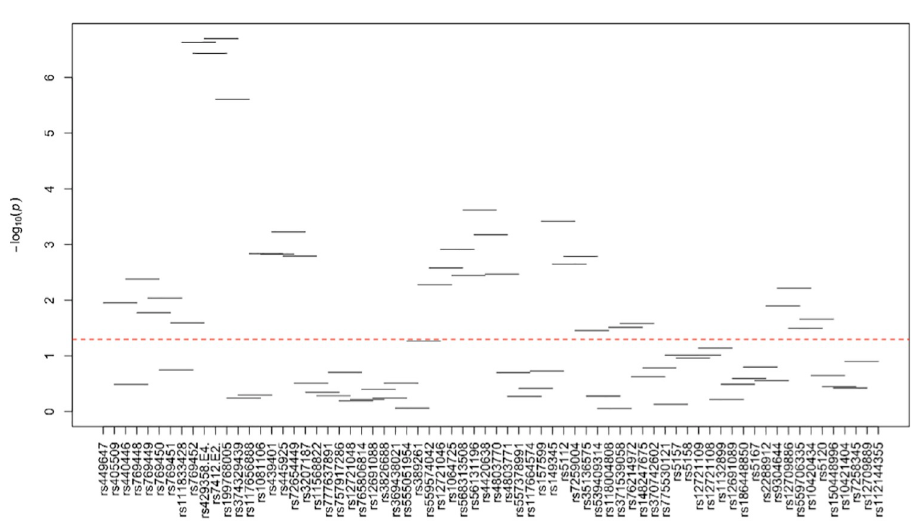
Fig 3. Plots of haplotype-based association analysis results for LDL-C in NHWs. Horizontal lines represent the 4-SNP windows. X-axis direction shows the SNPs genotyped in the regions based on the order of APOE , APOC1 , HCR1 , HCR2 , APOC4 and APOC2 while the Y-axis shows the–log (global p-value) with red line representing the p- value threshold (P = 0.05).